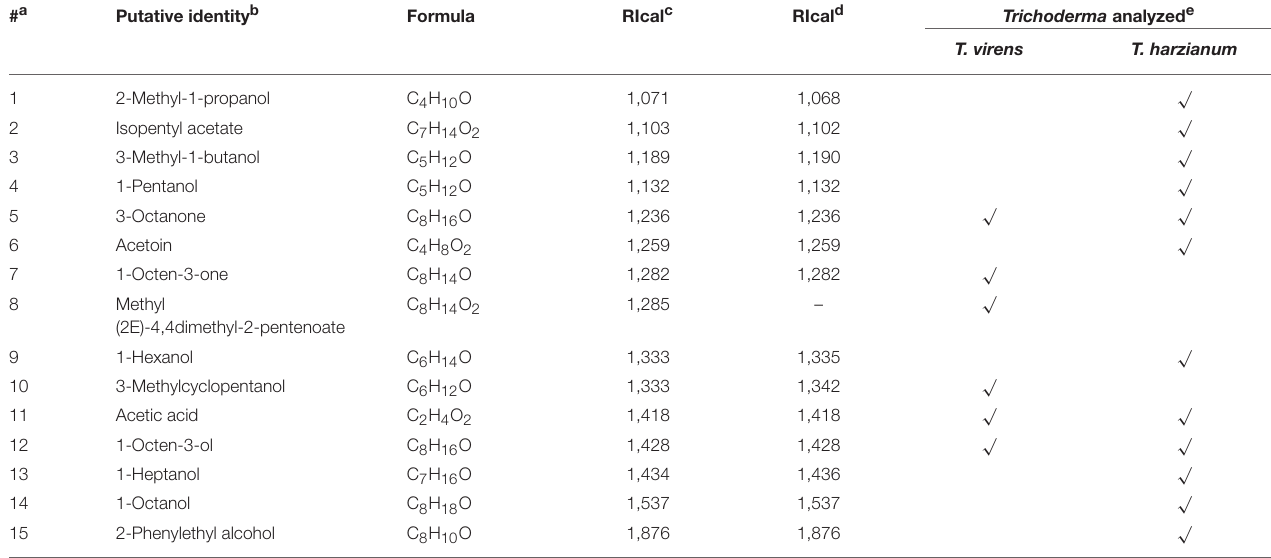
TABLE 3 | VCs produced by T. virens and T. harzianum